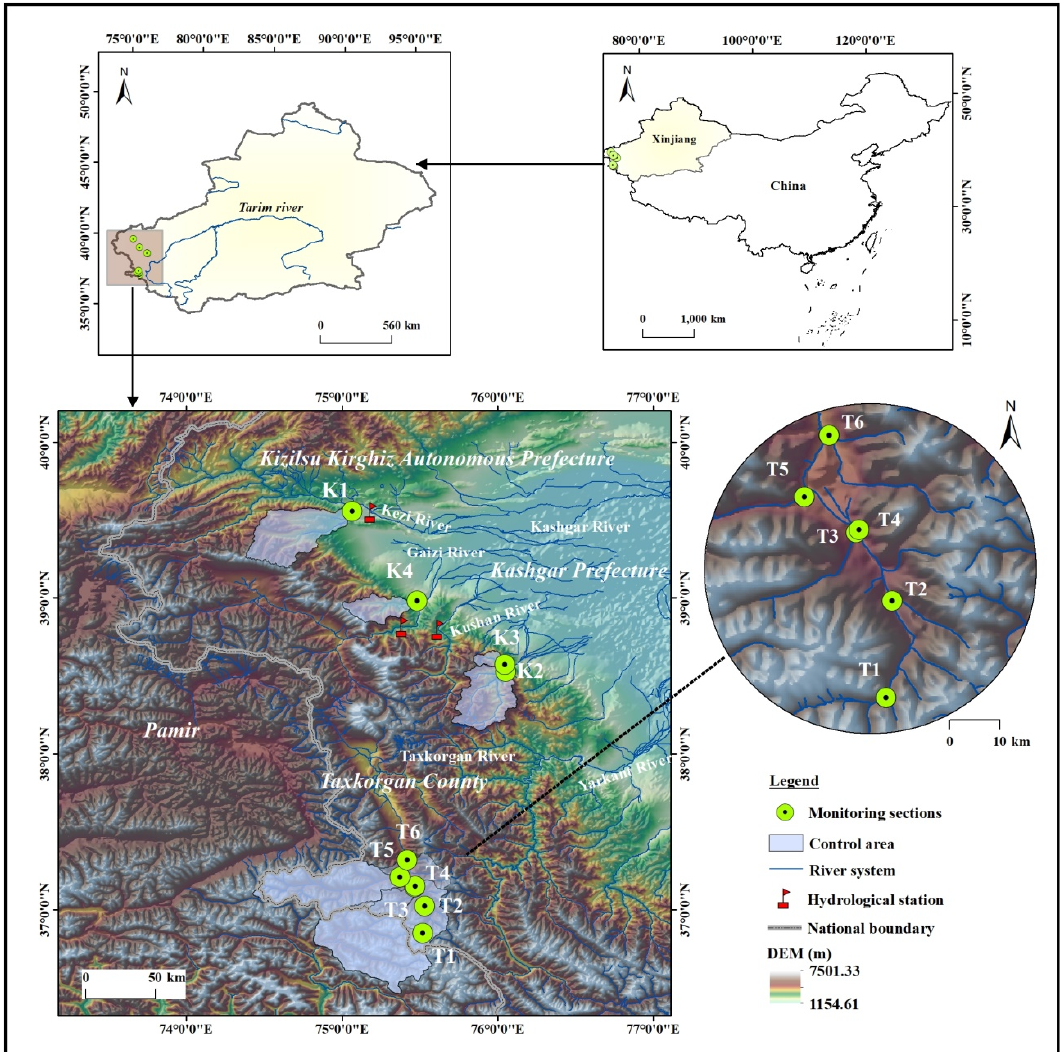
Figure 1. Locations of monitoring sections and their control